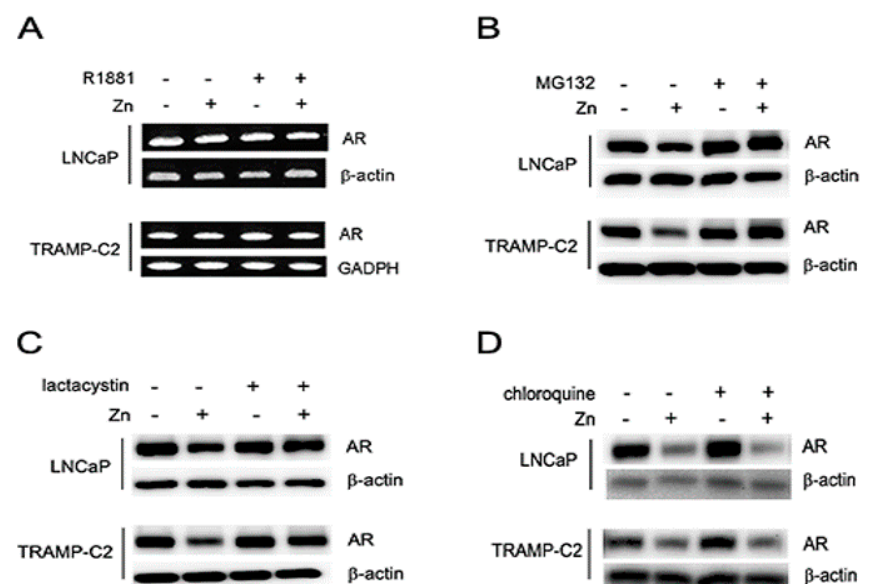
Figure 5. Zinc-mediated suppression of AR expression is facilitated by proteasomal degradation. ( A ) AR RNA levels were verified by RT-PCR analysis. ( B , D ) LNCaP (150 µ M) and TRAMP-C2 (75 µ M) cells were treated with zinc for 4 h followed by the addition of either MG132 (25 µ M, ( B ), lactacystin (1 µ M), ( C ) or chloroquine (10 µ M). ( D ) Cells were analyzed by Western blotting.